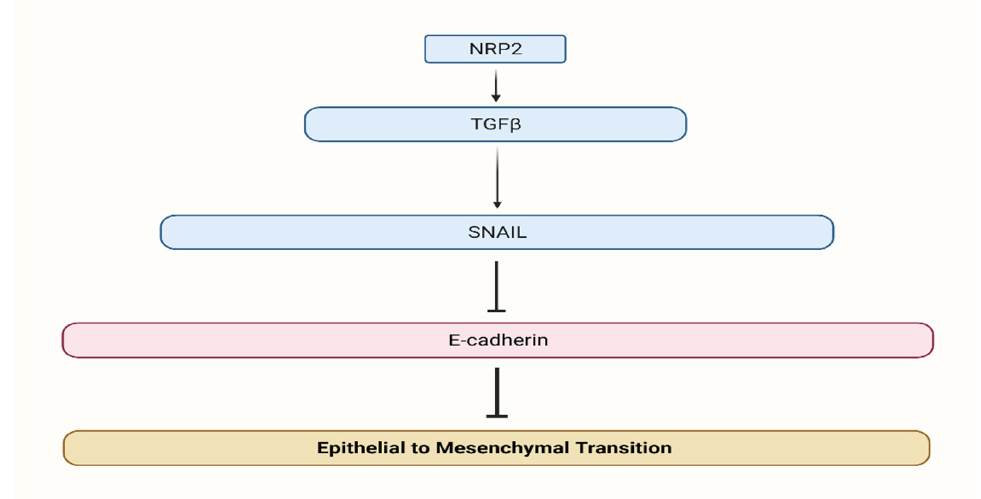
Figure 2. Neuropilin 2 regulatory mechanism. NRP2 promotes TGF β signaling and induces EMT.